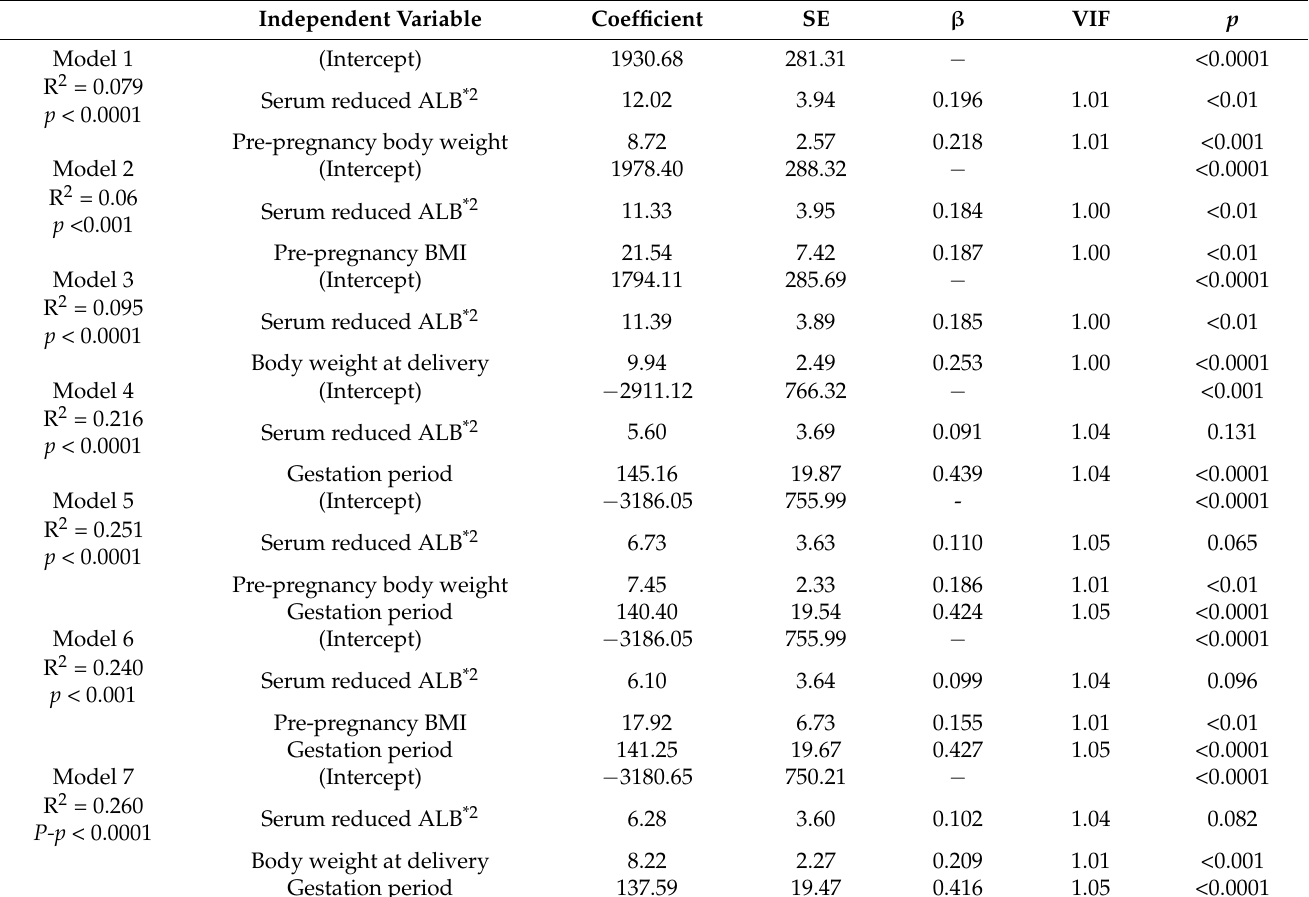
Table 3. Multiple linear regression analyses of maternal parameters vs. infant birth weight in pregnant women *1 .